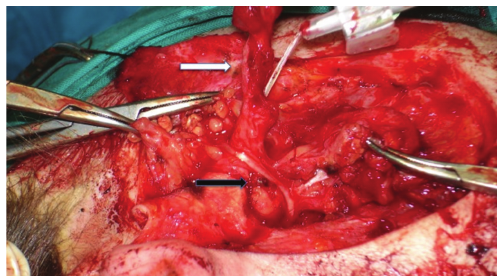
Figure 6: Superficial parotidectomy with complete excision of the fistula (white arrow—abbocath catheter), being between branches of the facial nerve exposed after performing a superficial parotidec- tomy (black